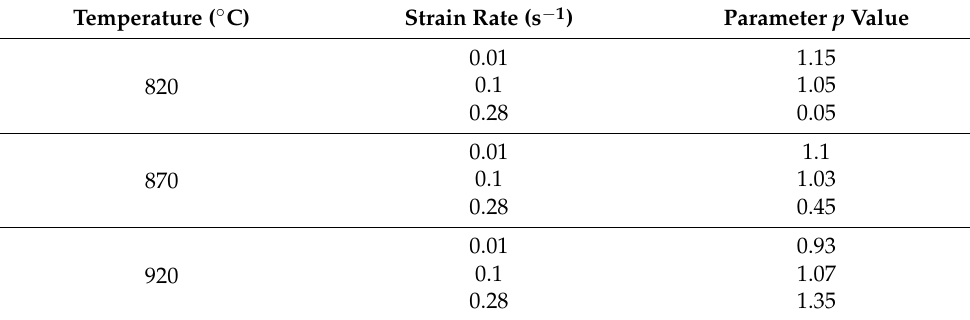
The p values obtained under different deformation conditions are shown in Table 1. Table 1. p -value obtained under different deformation conditions.